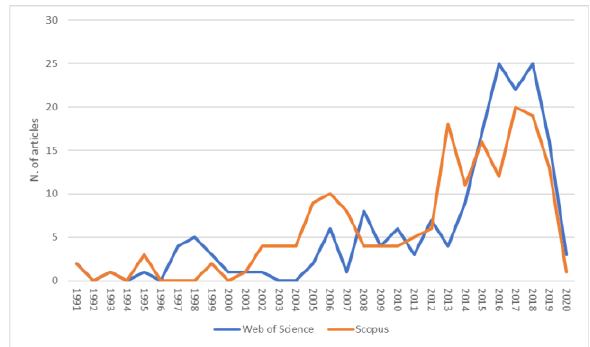
Figure 2. Published scientific literature